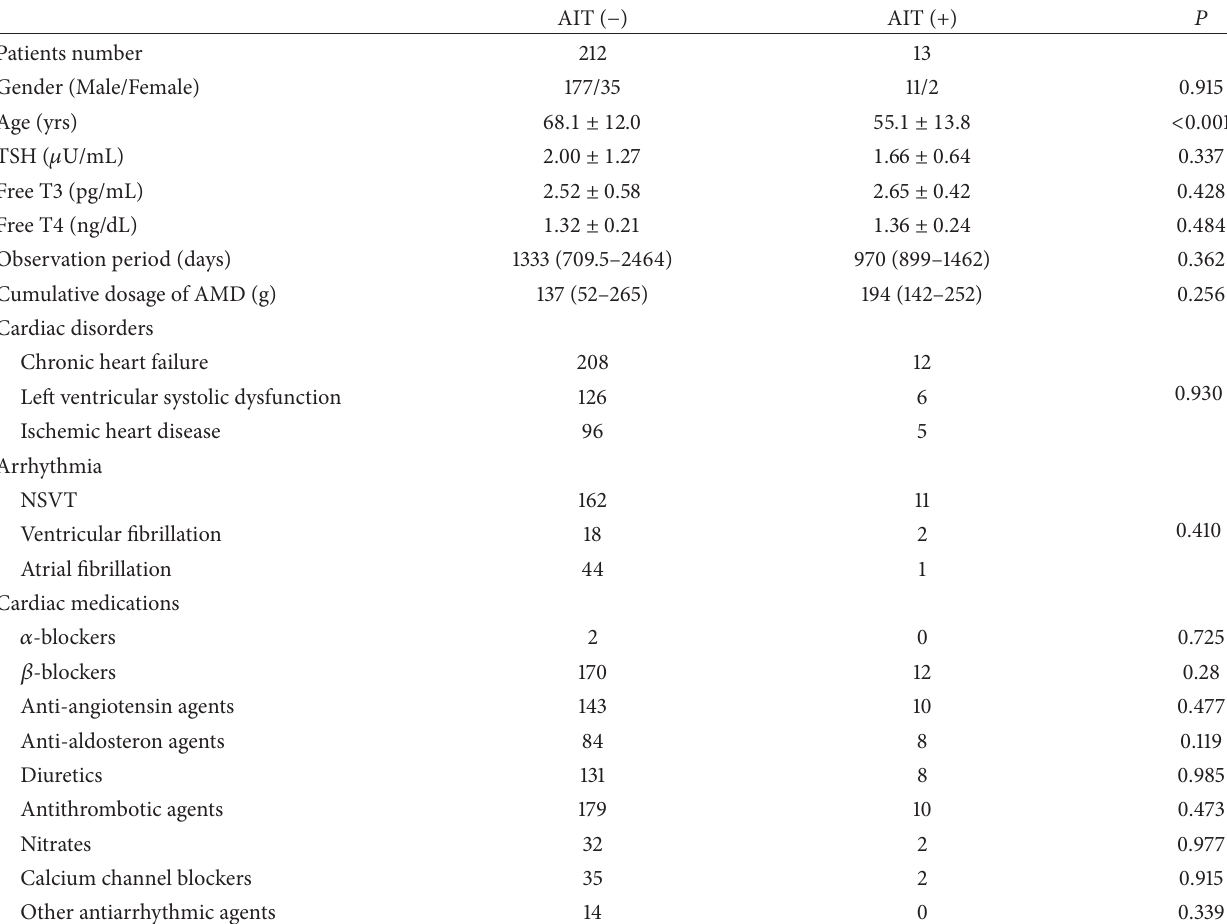
Table 1: Clinical features of patients treated with amiodarone with/without the onset of